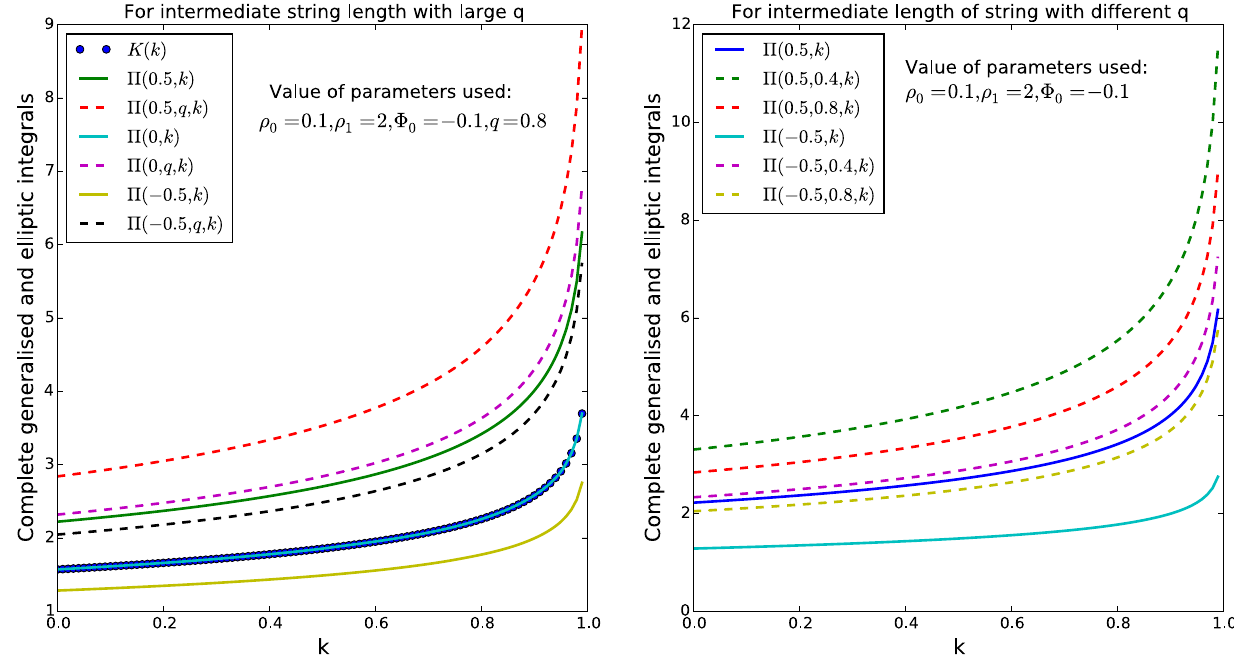
Fig. 4 Complete generalised integral (cid:14)( n + , q , k ) has been compared with complete elliptic integrals of third kind (cid:14)( n + , k ) under intermedi- ate string length for (i) fixed NS-NS flux with different n + and (ii) with